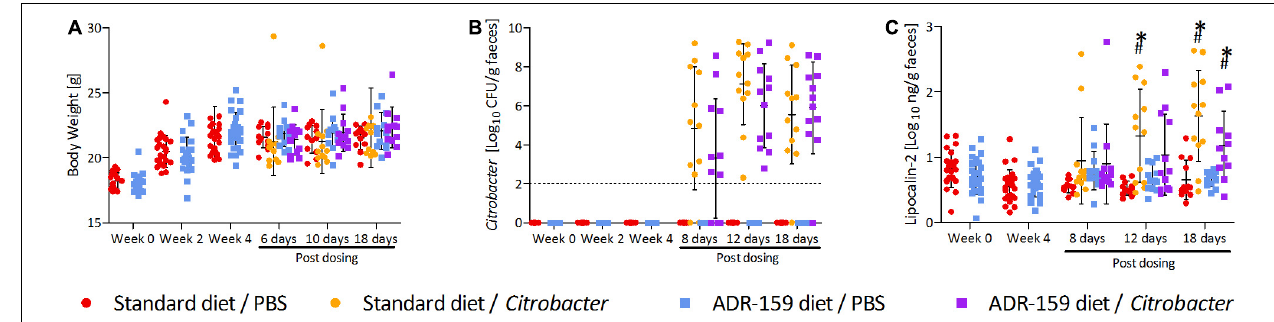
FIGURE 4 | Measurements for standard (circle) and ADR-159 (square) fed animals dosed with C . rodentium (orange, purple) or PBS (red, blue) before start of the diet, after 4 weeks of the diet (before dosing) and up to 18 days post-dosing (sacrifice). Error bars represent SD. (A) Body weight. (B) Average C . rodentium levels shed before and after initial dosing. (C) Fecal lipocalin-2 (LCN2) levels. ∗ Indicates significant change compared to standard diet/PBS, # indicates significant change compared to